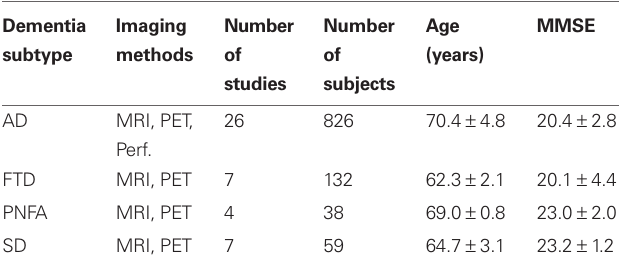
Table 1 | Demographic and clinical characteristics.